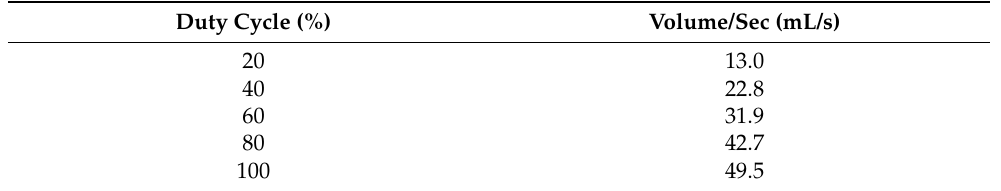
Table 1. Laboratory test on duty cycle vs. Volume rate.